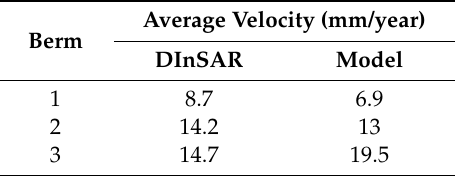
Table 8. DInSAR vs. model.